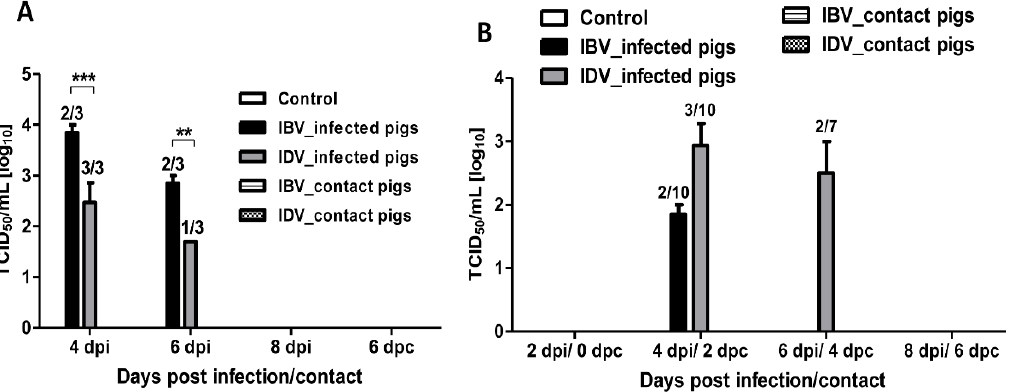
Figure 3. Virus titers in BALF and nasal swab samples collected from contact or infected pigs with IBV or IDV. ( A ) Mean of virus titers in BALF from contact or infected pigs with either IBV or IDV at indicated days. ( B ) Mean of virus titers in nasal swabs from contact or infected pigs infected with either IBV or IDV at indicated days. None of the contact pigs had virus in lung or nasal turbinates. Determination of virus titers was performed by calculating the 50% tissue culture infective dose (TCID 50 ) / mL in Madin–Darby canine kidney (MDCK) cells using indirect immunofluorescence assay (IFA). The number of pigs with positive virus isolation out of the total number of tested pigs is presented above of each bar. The error bars represent SEM. The asterisks (*) represent a statistically significant difference between groups (**: p < 0.01, and ***: p < 0.001).